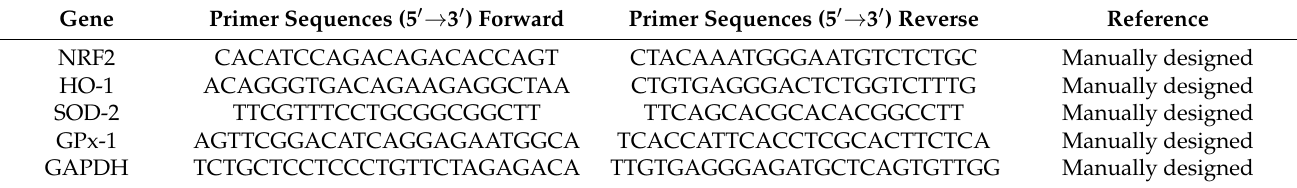
Table 1. The primer sequence utilized in this